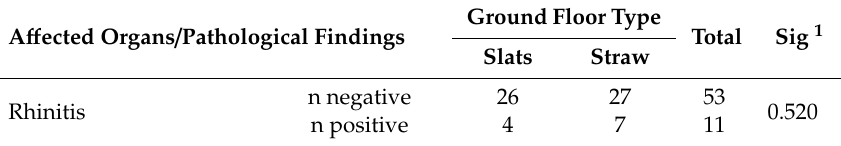
Table 4. Number (n) of main and secondary pathological alterations. Positive findings (positive) versus no findings (negative). Diagnoses are based on necropsy of 64 rabbits reared in pens with the ground floor consisting of slatted plastic floor panels (Slats, n = 30) or pens with the ground floor consisting of concrete littered with straw litter (Straw, n =